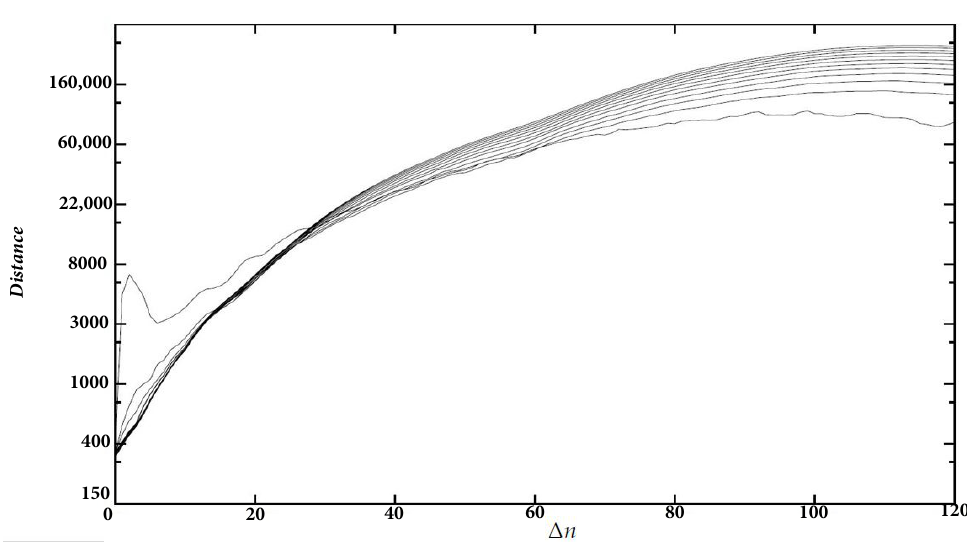
Figure 9. e S ( ∆ n ) for coop3 ( ε = 1000).